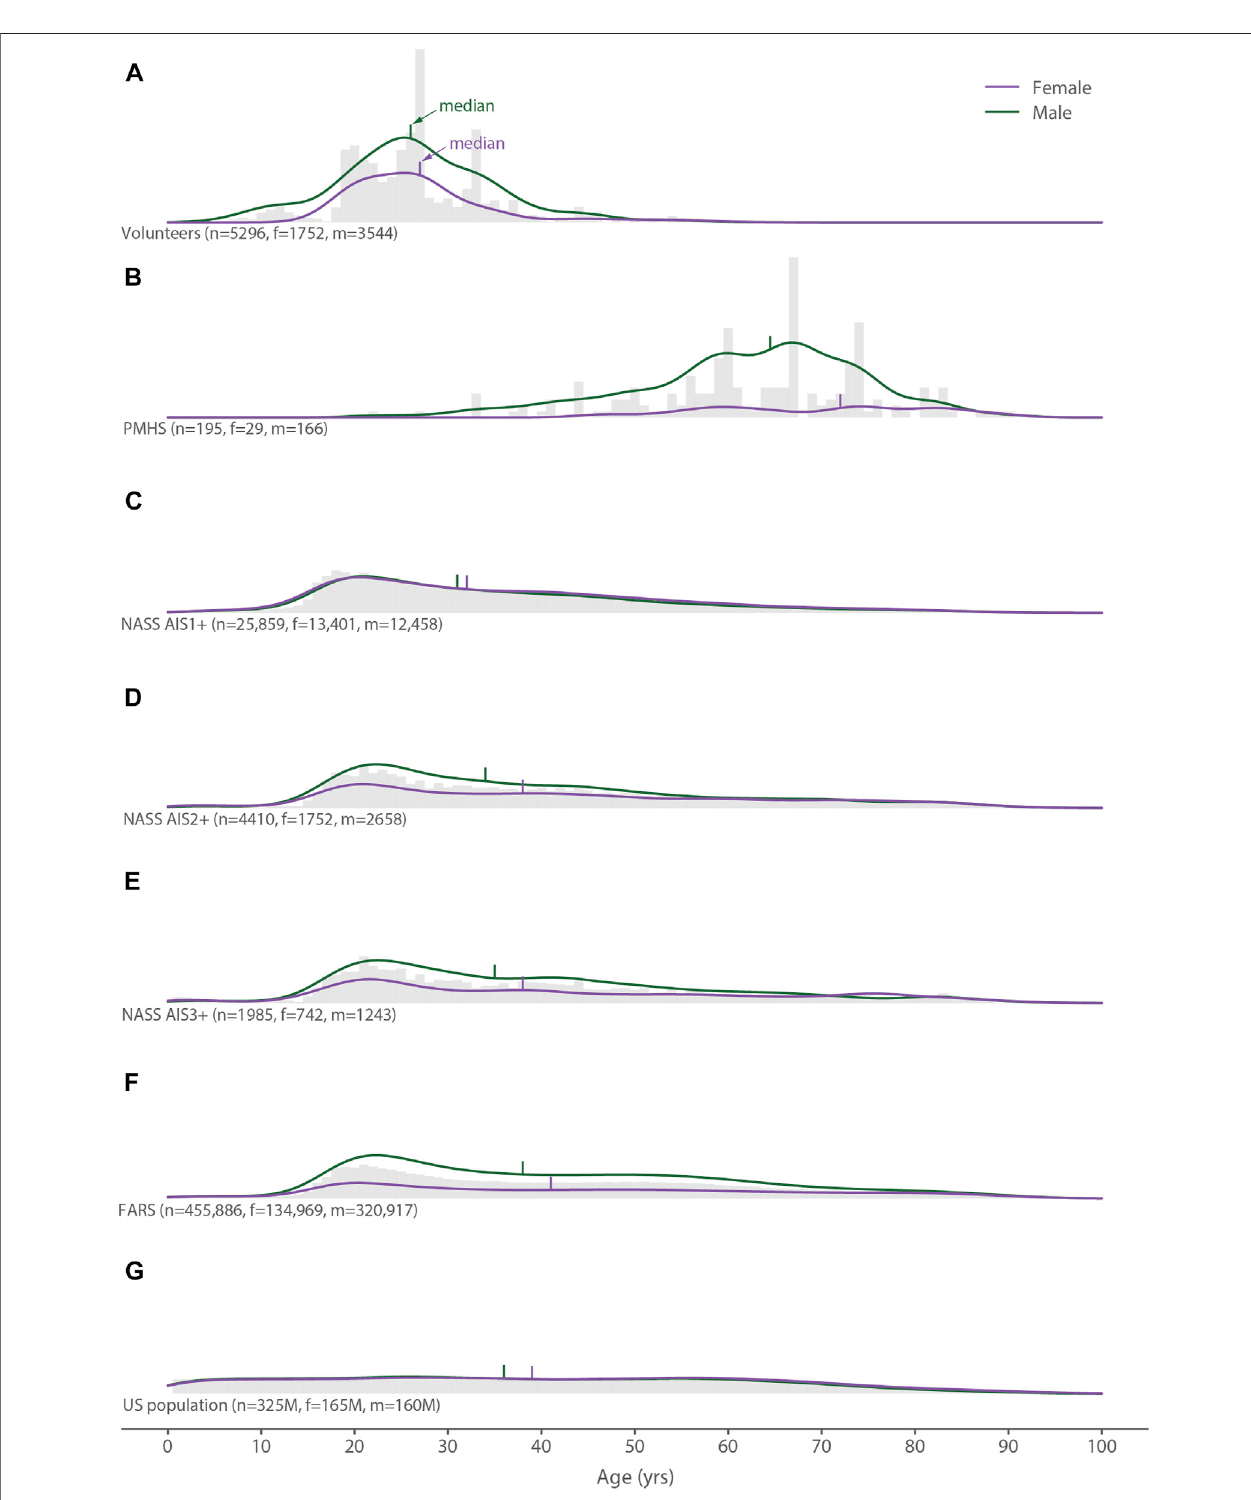
FIGURE2| Distributionofallagedata(grayhistograms),females(purplelines),andmales(greenlines)for (A) thevolunteertests, (B) thePMHStests, (C) theNASS AIS1+ data, (D) the NASS AIS2+ data, (E) the NASS AIS3+ data, (F) the FARS data, and (G) the United States population.